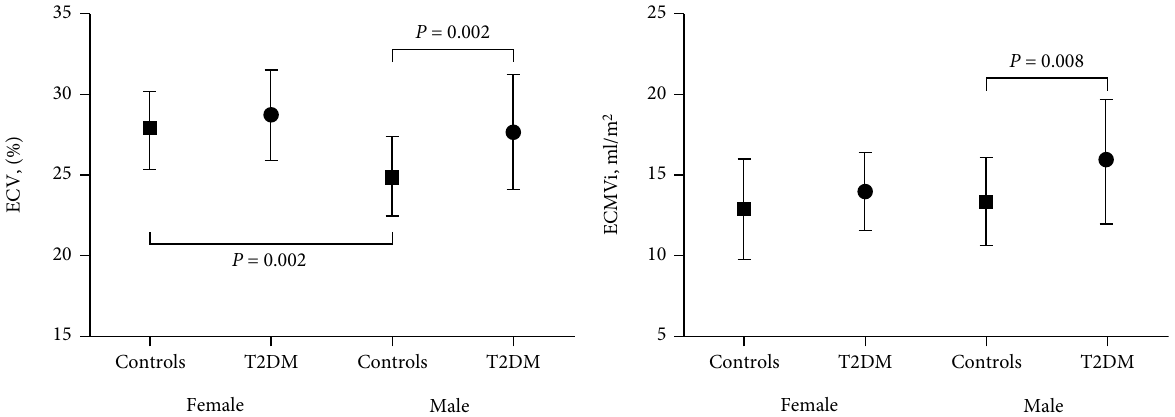
Figure 2: Sex di ff erences in myocardial tissue characteristics between control and T2DM subjects. ECV: extracellular volume fraction; ECMVi: extracellular matrix volume index.